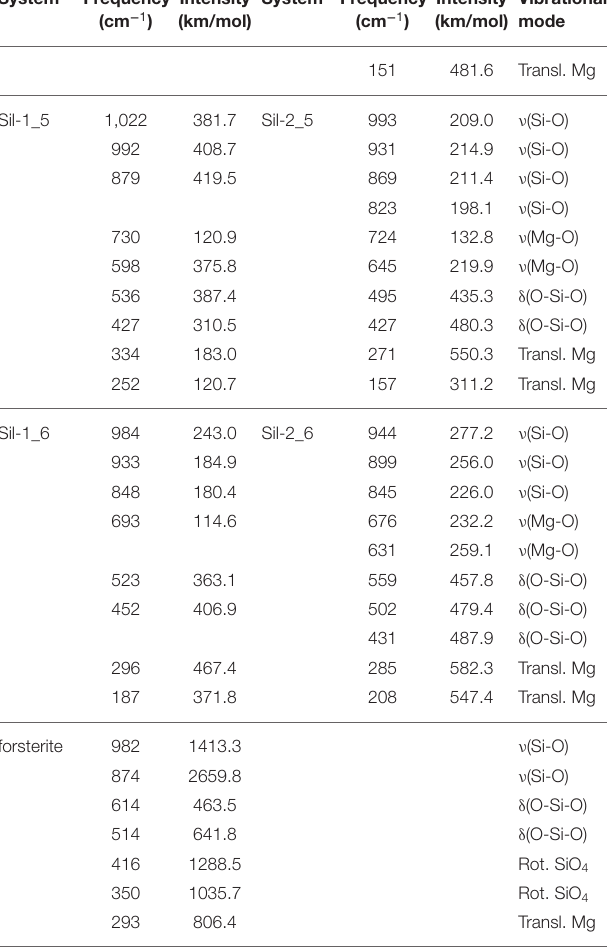
TABLE 3 | Calculated frequencies and intensities, and assignment of the corresponding vibrational modes of the IR bands for the studied systems. System Frequency (cm − 1